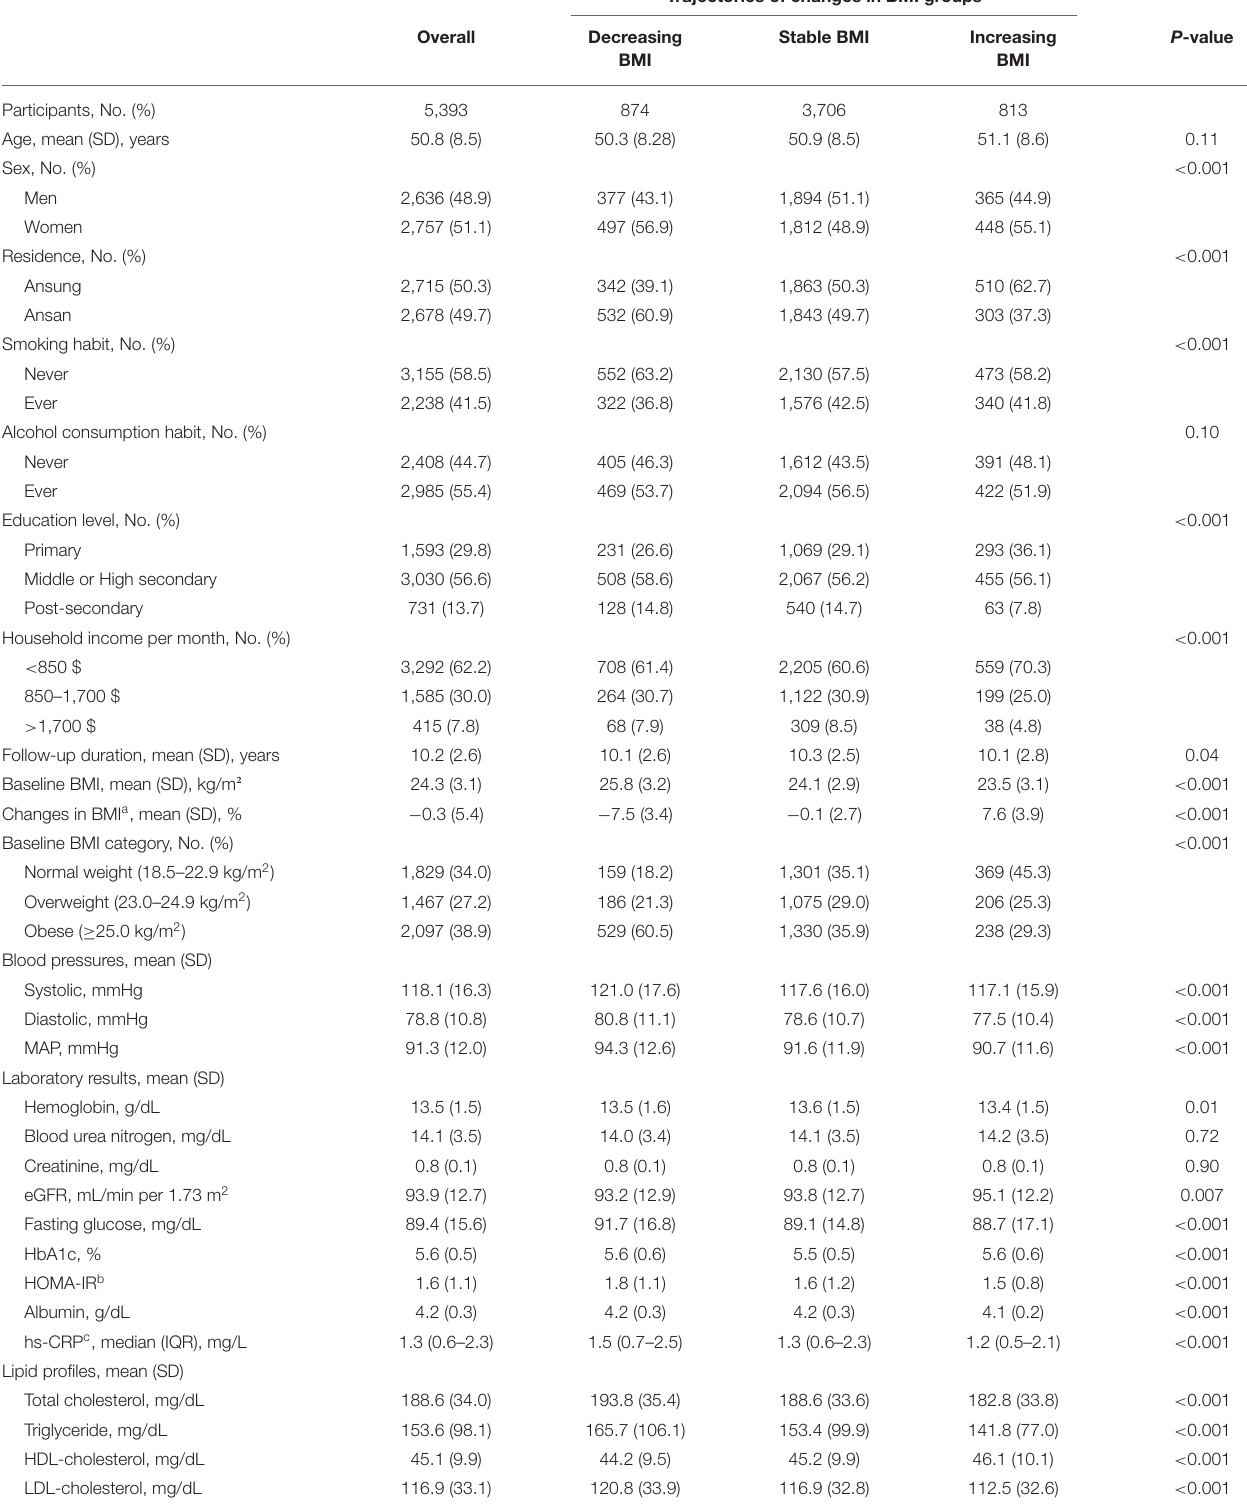
TABLE 1 | Baseline characteristics of the trajectories of changes in the body mass index (BMI) groups.